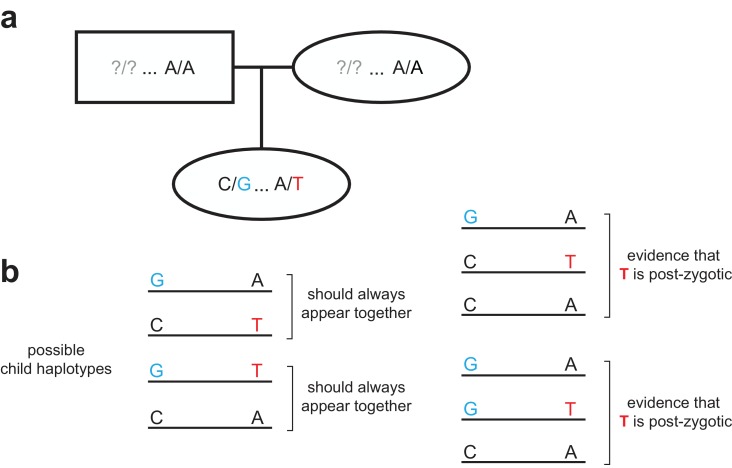
Strategy for identifying post-zygotic DNMs using two generations.(a) Diagram of an example two-generation pedigree structure that is amenable to the post-zygotic detection strategy. In this example, the child has a de novo ‘T’ allele that is <= 500 bp downstream of a heterozygous ‘G’ allele. Question marks in the parents indicate that the child could have inherited the ‘G’ allele from either parent; unlike the read tracing strategy (Figure 1—figure supplement 2), a particular parent does not need to be ‘informative.’ (b) In the child’s reads, only two possible sets of linked haplotypes should be seen, assuming the de novo allele occurred in the germline of a parent. The presence of three distinct haplotypes, demonstrating incomplete linkage of the de novo and heterozygous alleles, indicates that the de novo ‘T’ allele is post-zygotic.